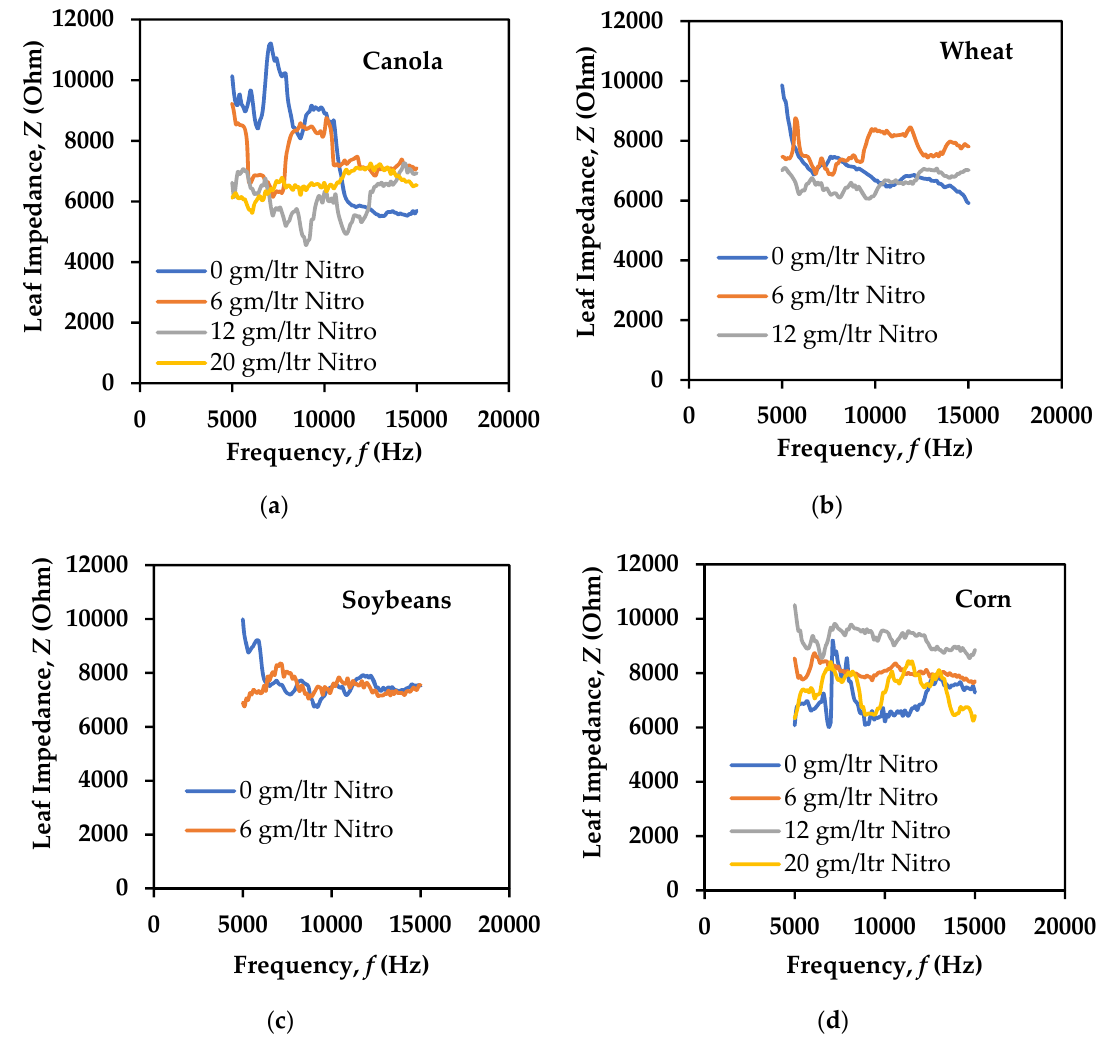
Figure 2. Plots of frequency versus leaf impedance. ( a ) canola; ( b ) wheat; ( c ) soybeans; and ( d ) corn at different nitrogen fertilization levels. The impedance profile for a few samples of wheat and soybeans could not be taken because of the effects of high nitrogen fertilization.